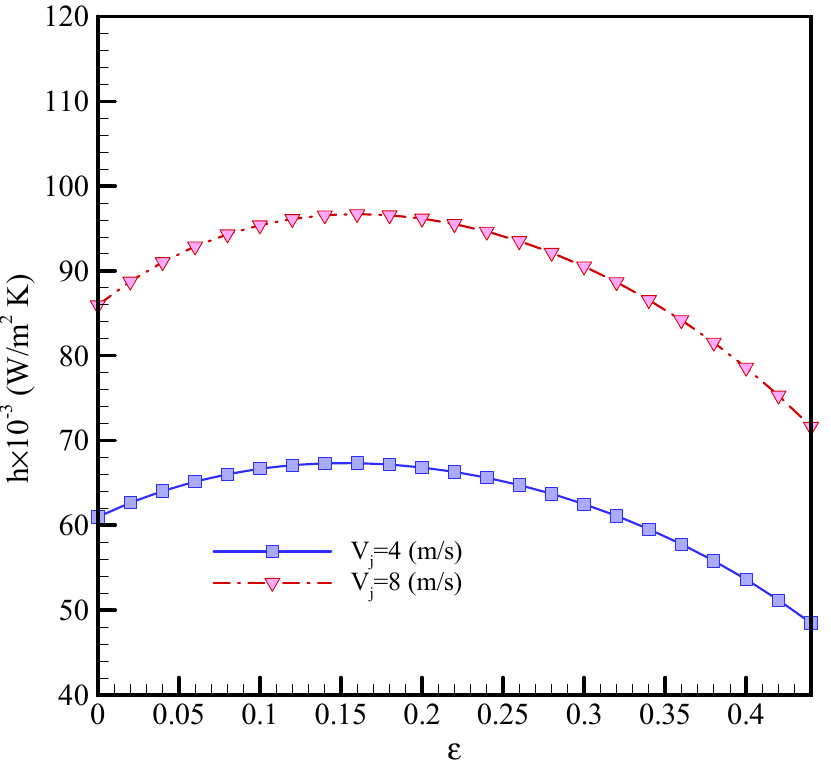
Figure 11. The variation of heat transfer coefficients as function of particle volume fraction for the two different jet velocities.